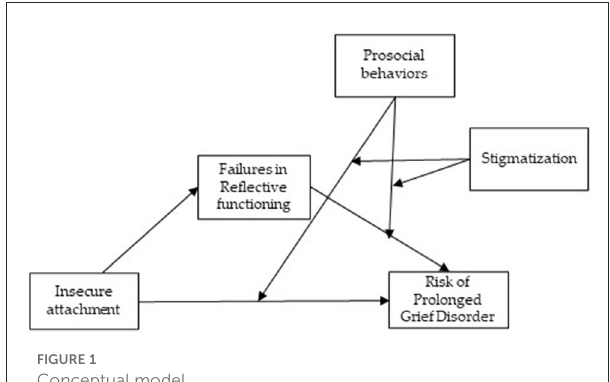
FIGURE1 Conceptual